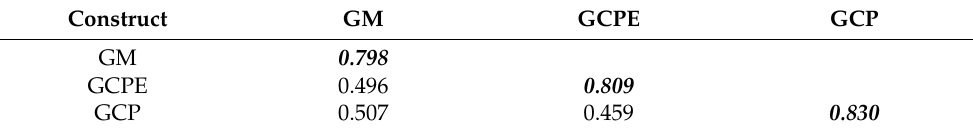
Table 3. Constructs’ discriminant validity.